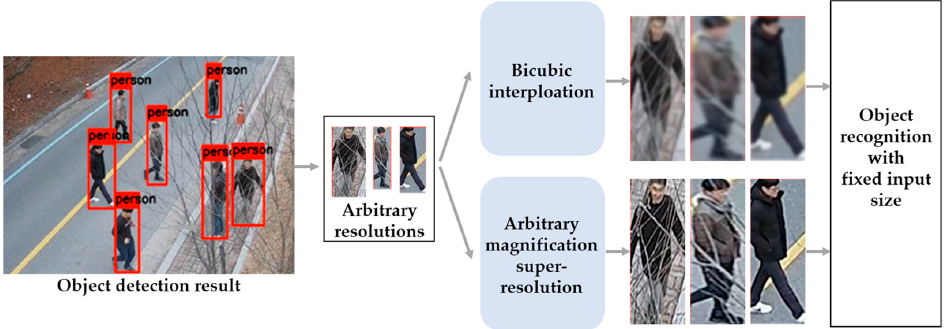
Figure 1. Example application of arbitrary magnification super-resolution in object recognition task.